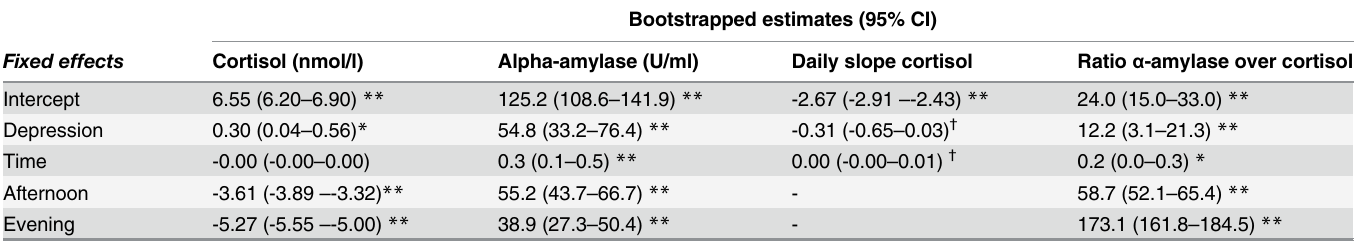
Table 2. Results of multilevel analysis of relationship between depression status and cortisol and α -amylase